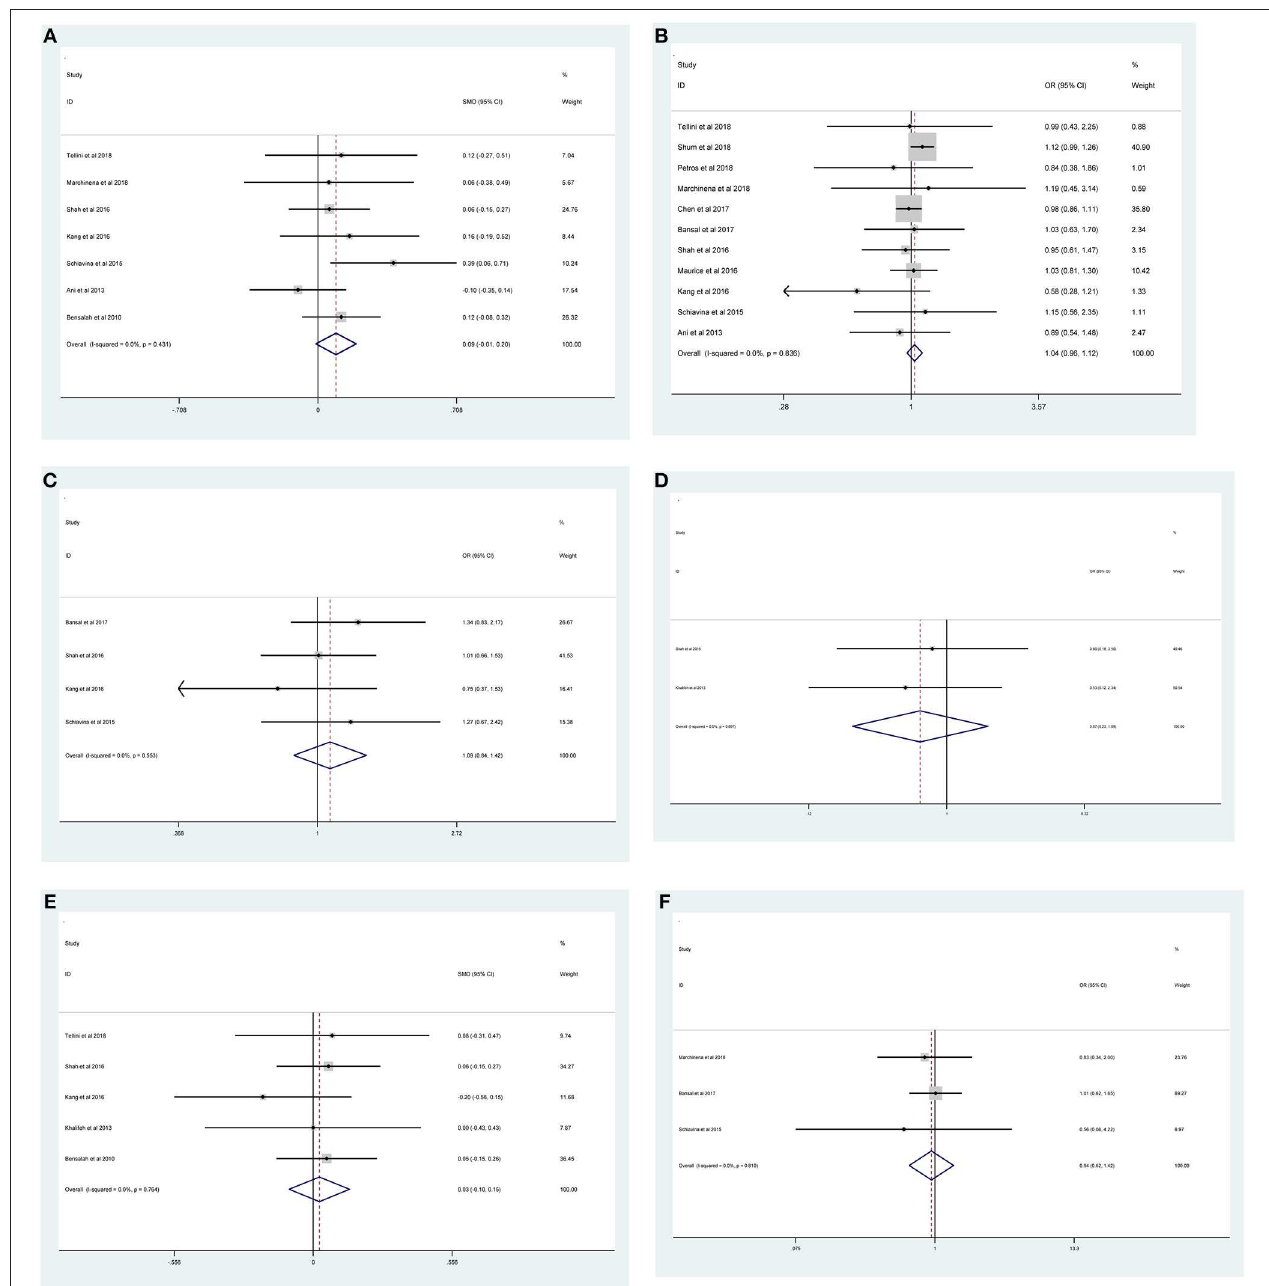
FIGURE 3 | Forest plots of studies evaluating the association of PSMs and clinicopathological features in RCC patients. (A) age, (B) gender, (C) tumor laterality, (D) tumor focality, (E) tumor size, and (F) surgical approach.